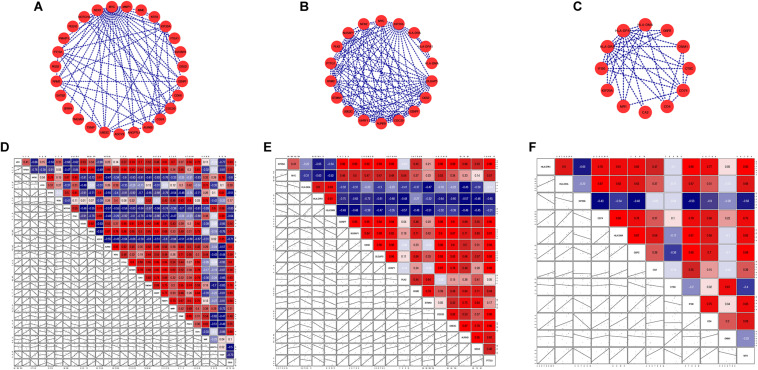
Sub-networks (A–C) and correlation matrixes (D–F) of hub genes and their first neighbors: (A,D)
MYC; (B,E)
KIF20A; (C,F)
HLA-DRA and HLA-DPA1.